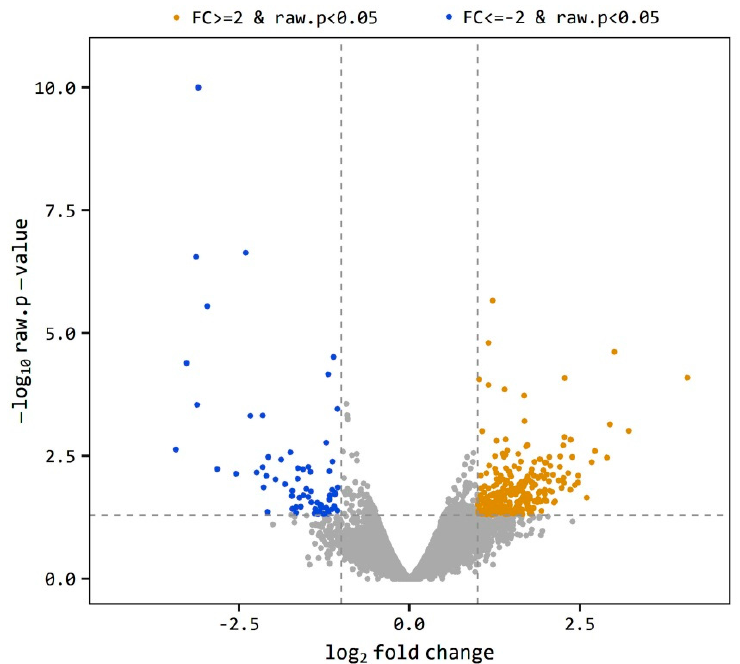
Figure 1. Volcano plot of expression level distribution of differential expressed genes (DEGs) in the testis of obese and control rats with |FC| ≥ 2 (brown dots) and |FC| ≥ 2 (blue dots), p < 0.05. The expression level is expressed as O/C.